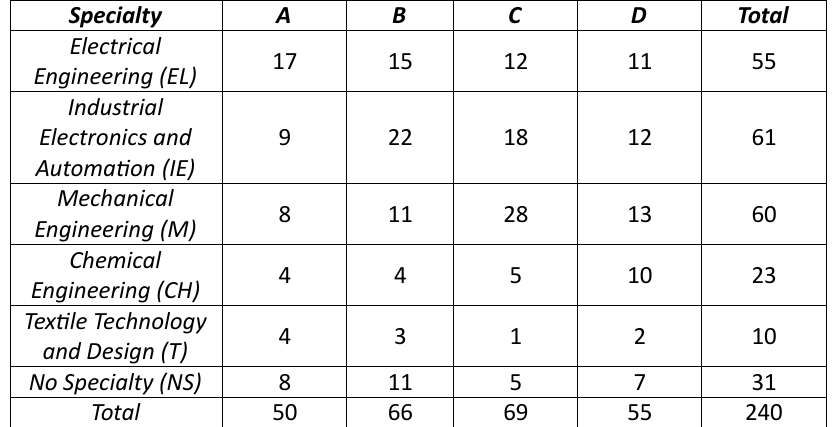
Table 2. Distributon of students by specialtes and groups. Academic year 2012/2013